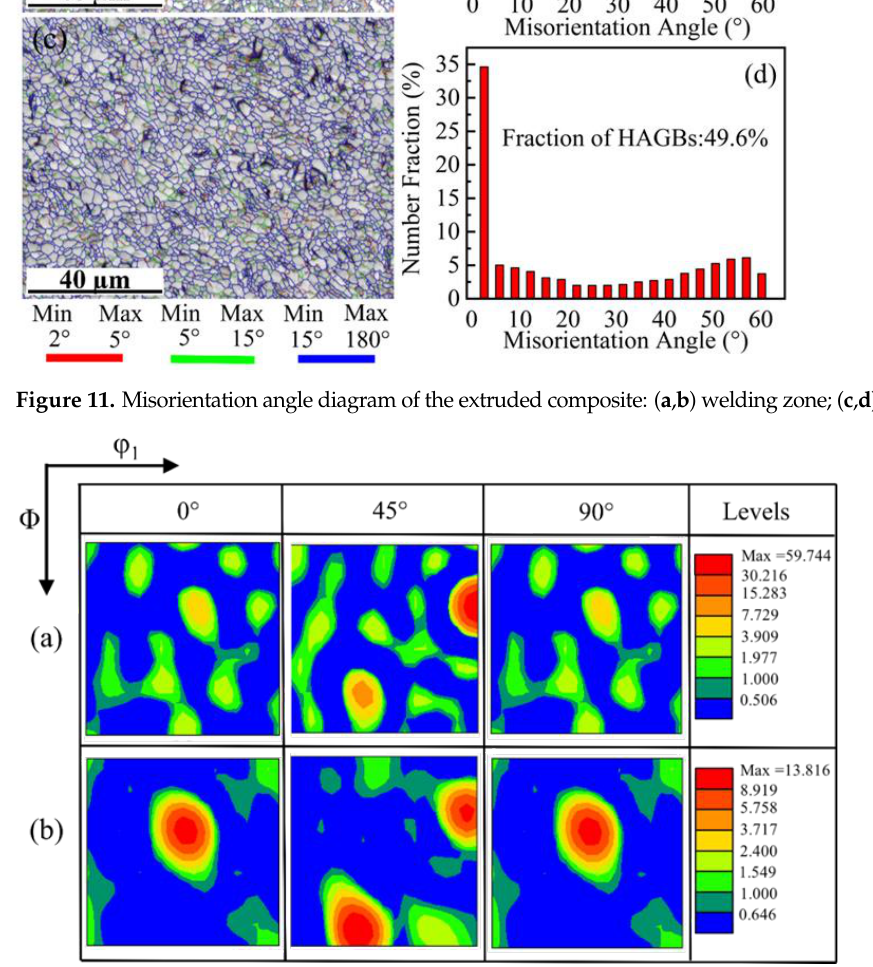
Figure 11. Misorientation angle diagram of the extruded composite: ( a , b ) welding zone; ( c , d ) matrix zone.